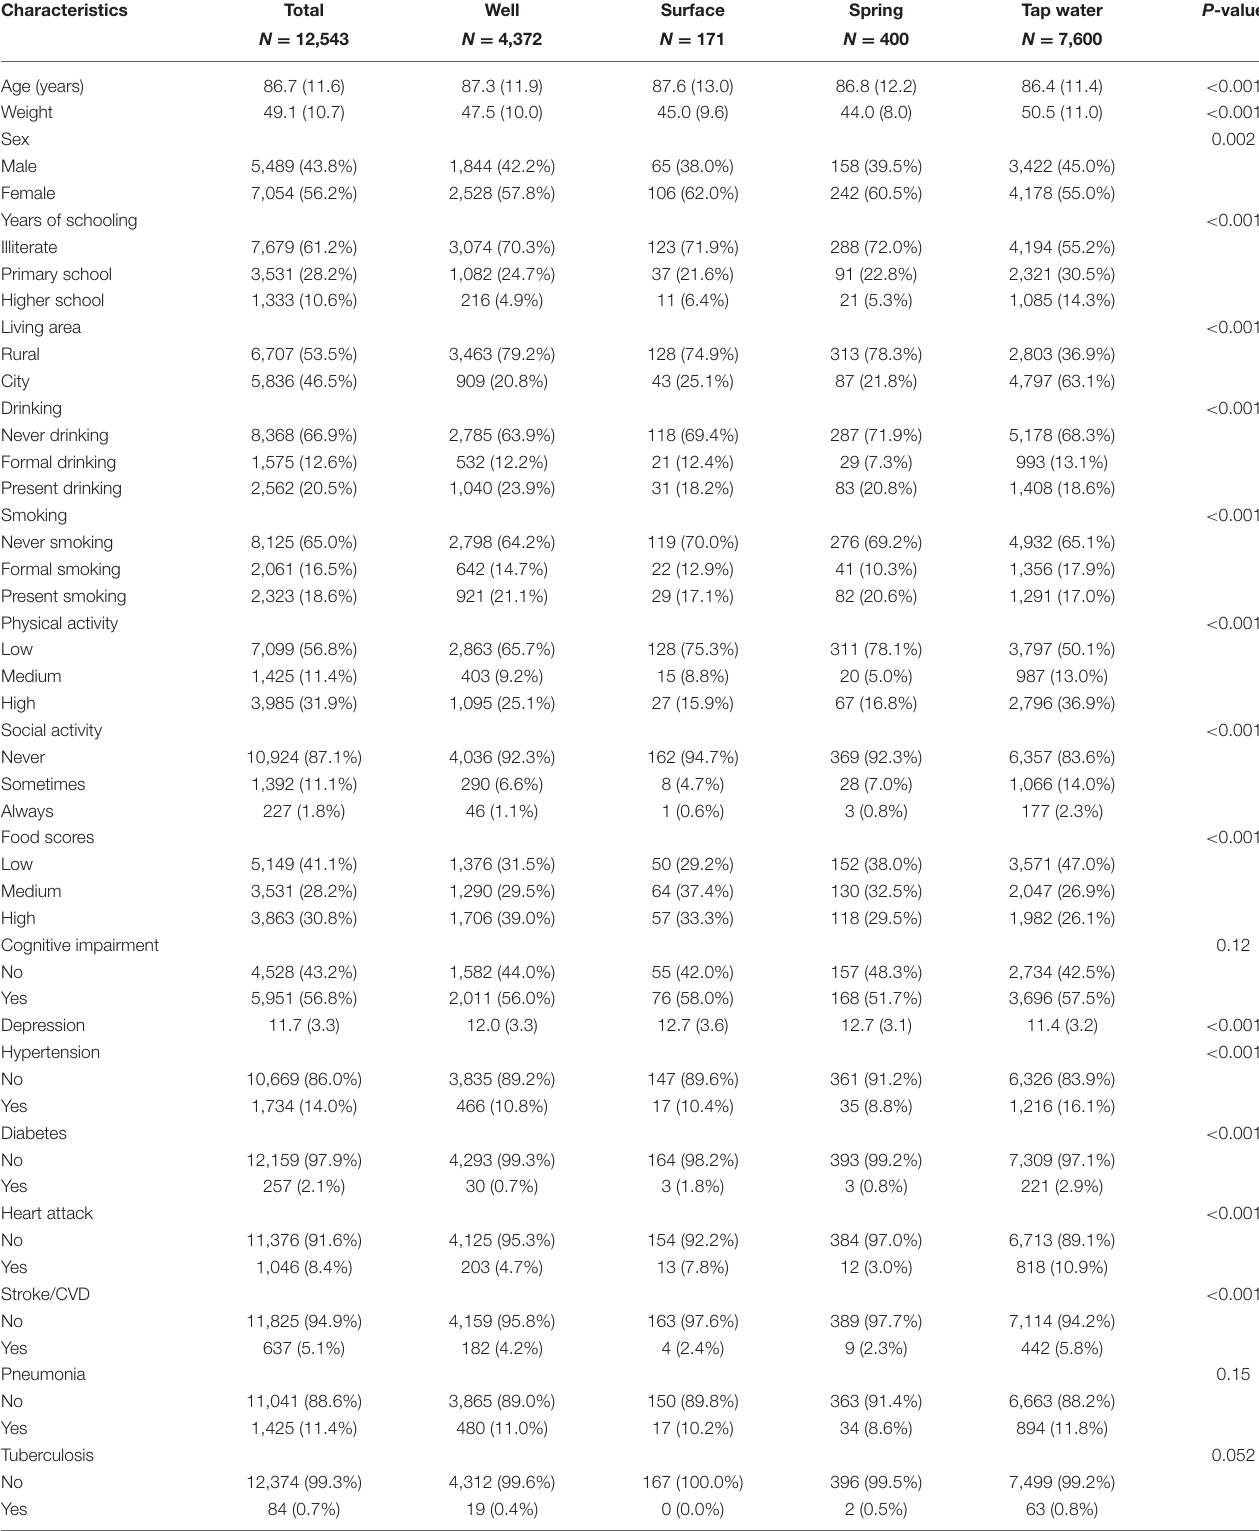
TABLE 1 | Characteristics of 12,543 participants aged over 65 years and older according to CLHLS.